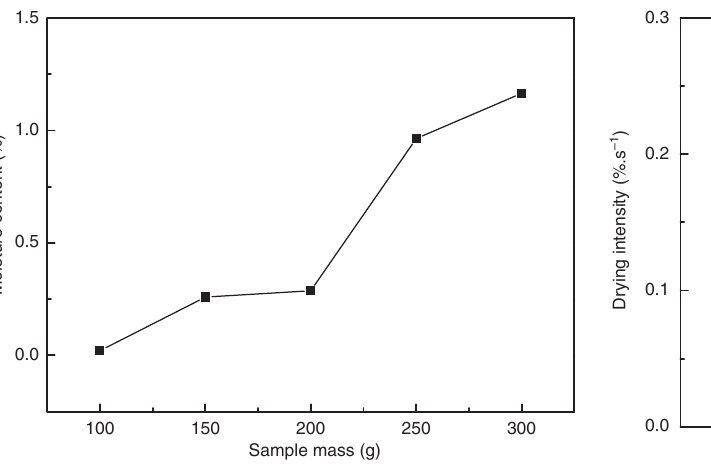
Figure 13: The drying intensity curve of high titanium slag under microwave